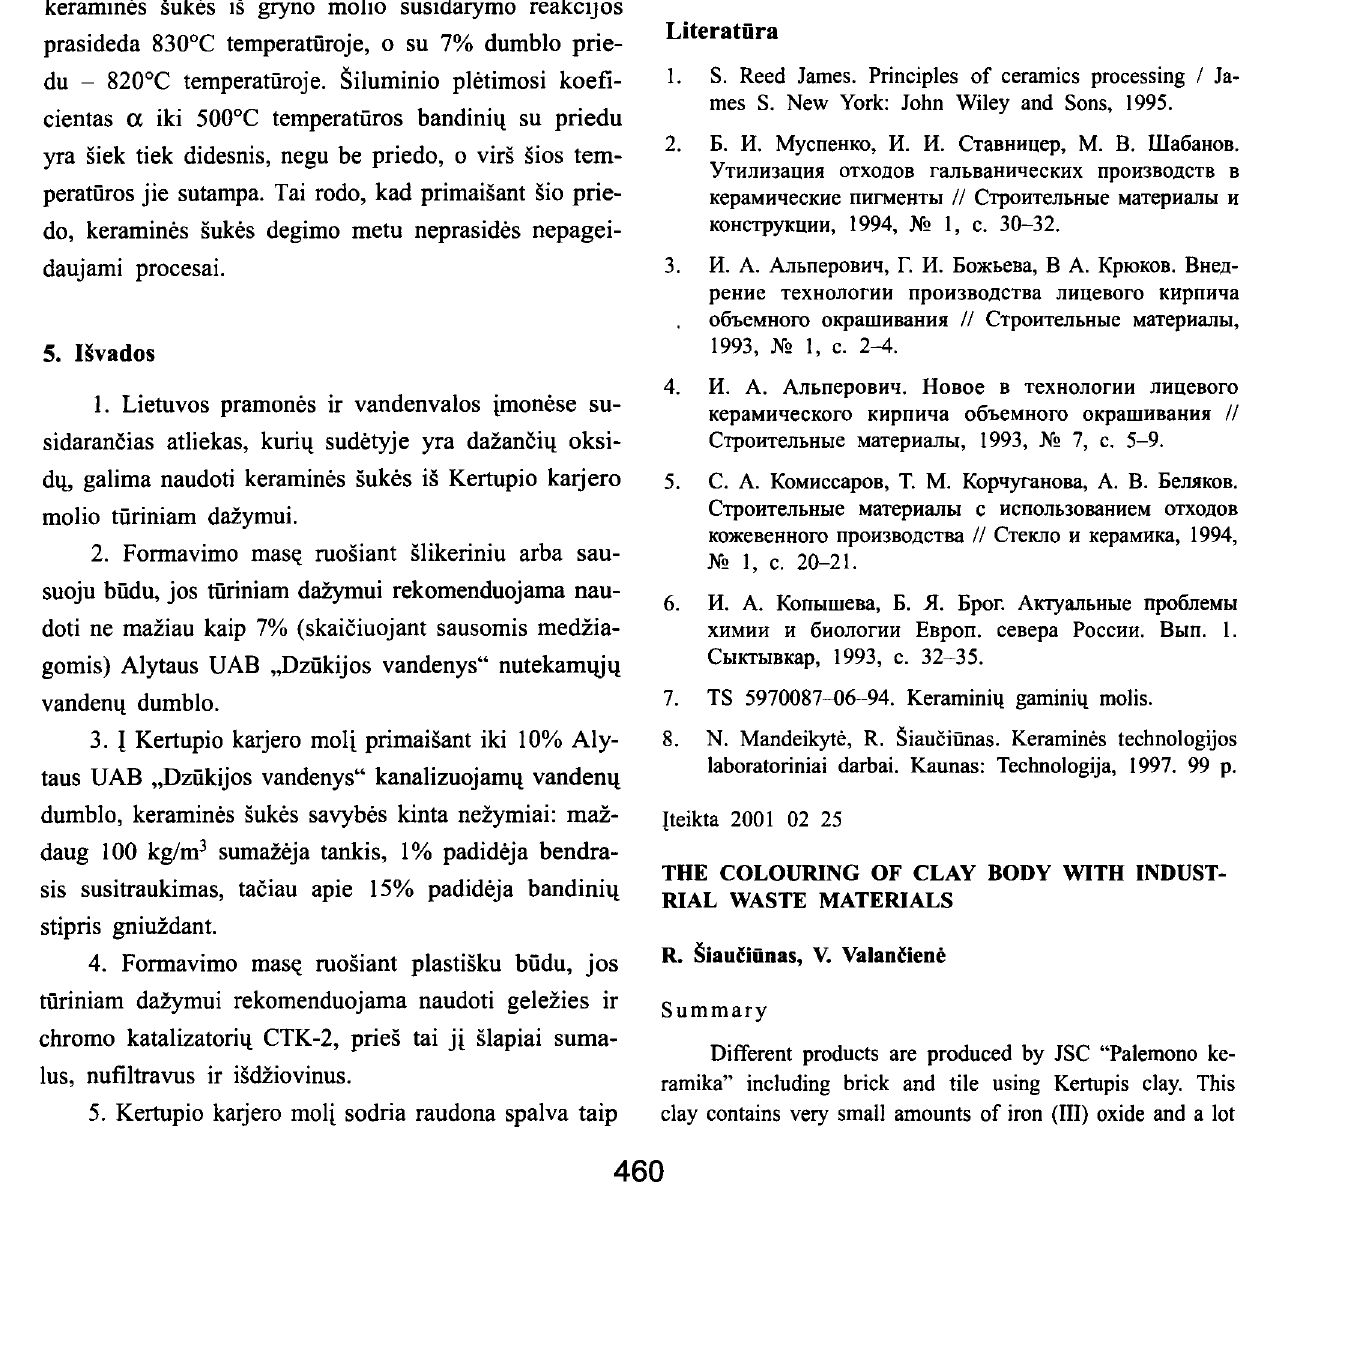
dumblo ~I,% 0,043 0,109